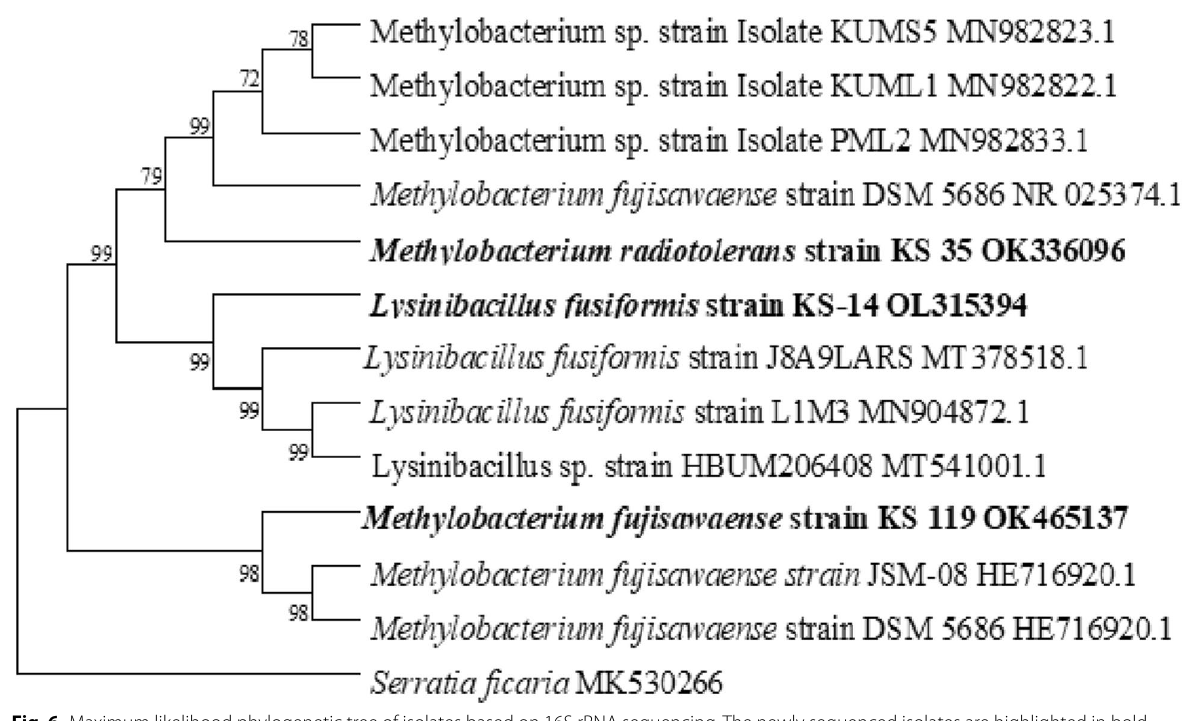
Fig. 6 Maximum likelihood phylogenetic tree of isolates based on 16S rRNA sequencing. The newly sequenced isolates are highlighted in bold. NCBI accession numbers of the respective sequences are noted behind the species